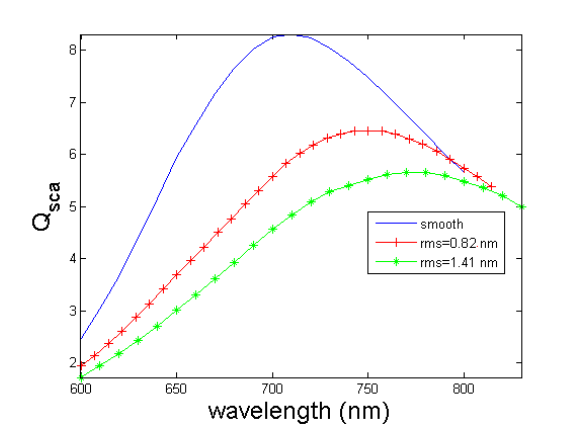
Figure 8: Scattering efficiency spectra of nanoantenna- based biosensor for smooth (blue curves) and rough topog-